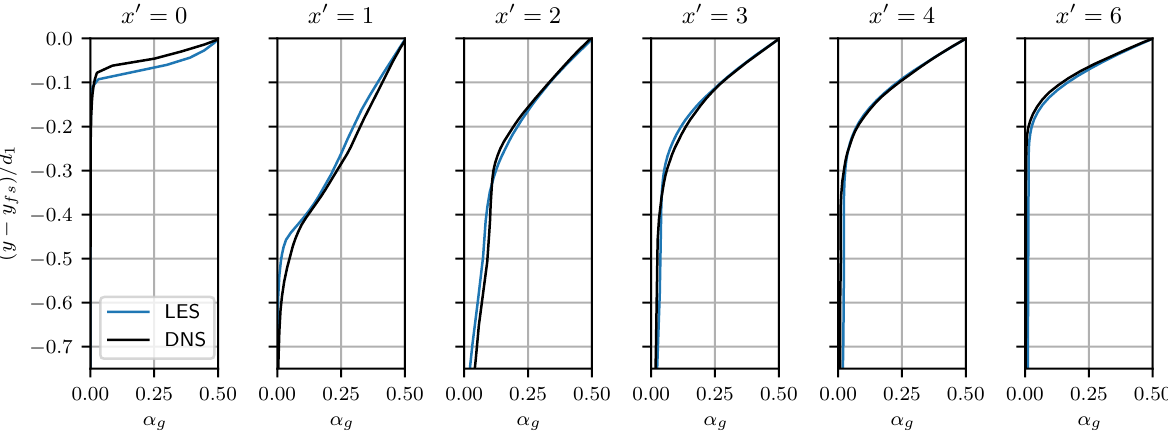
Figure 5. The profiles of (cid:104) α (cid:105) in the benchmark simulation. The mean streamwise and vertical velocity profiles are shown in Figure 6. The hori- zontal magenta lines show the positions of (cid:104) α 0.5 (cid:105) . Excellent agreement with the reference was obtained at all six streamwise positions. A noticeable deviation was only observed in the values of the vertical velocity of the air, which are not of particular interest and can be significantly affected by the boundary condition at the top of the